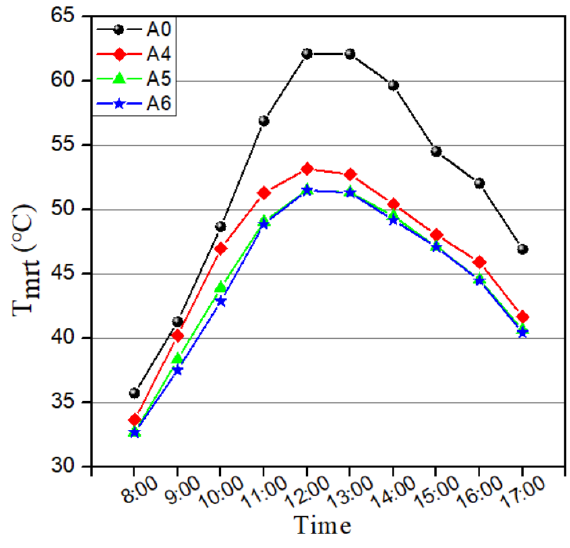
Figure 14. T mrt of the base case and cases with different H/W.